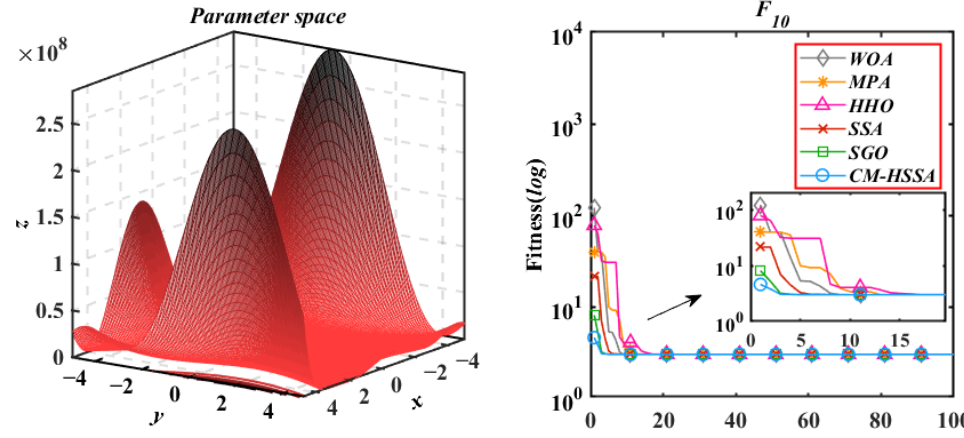
Figure 19. Goldstein − Price Function.